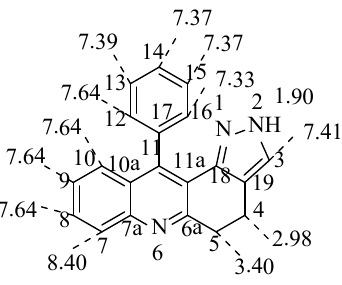
Figure 3: Summary of Proton d Values 4a.